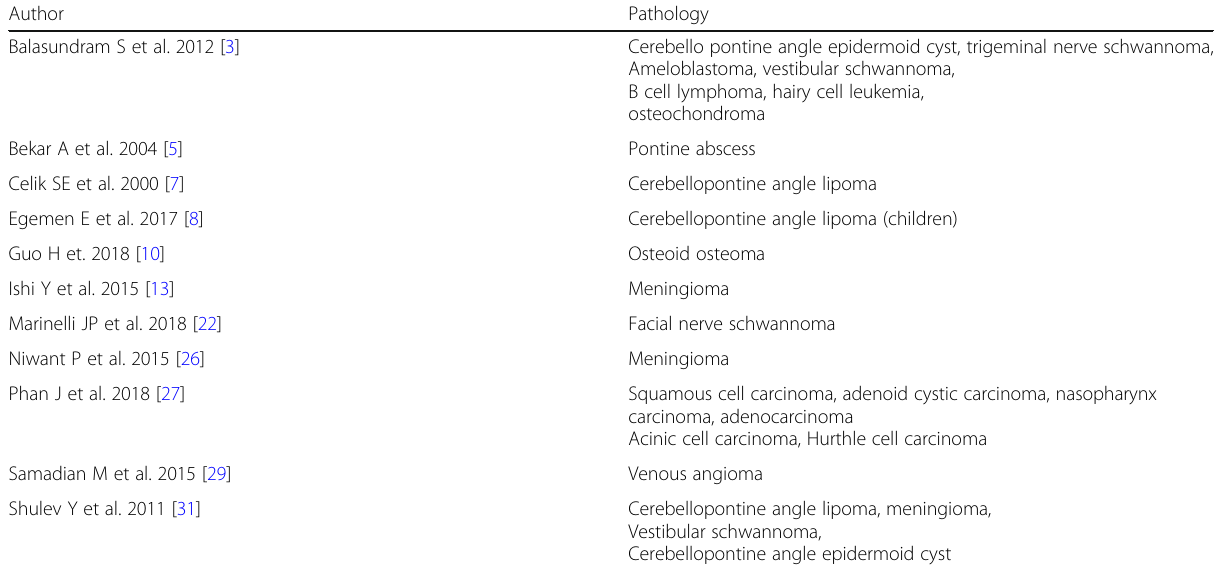
Table 1 Trigeminal neuralgia and concomitant intracranial lesions reported in the